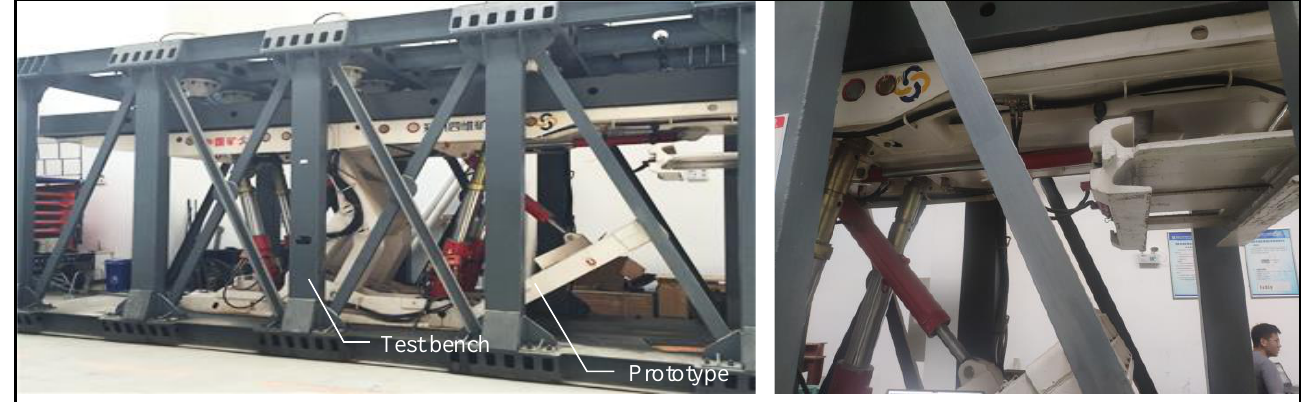
Figure 2. Prototype test of backfilling hydraulic support.